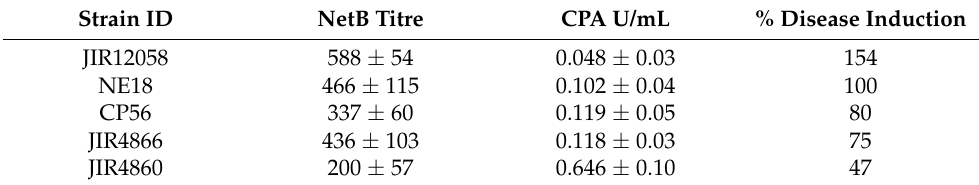
Table 2. Overview of the NetB and Alpha toxin production of 5 C. perfringens strains with different virulence. All strains were grown in TGY medium for 24 h, after which both the NetB titre (super- natant dilution that induces 50% of haemolysis) and alpha toxin activity (CPA in units/mL) in the supernatants were determined. The virulence of the strains is expressed as % disease induction in an NE in vivo model, relative to the virulence of strain NE18 [23]. Data are expressed as mean ± standard deviation of the mean. Strain ID NetB Titre CPA U/mL